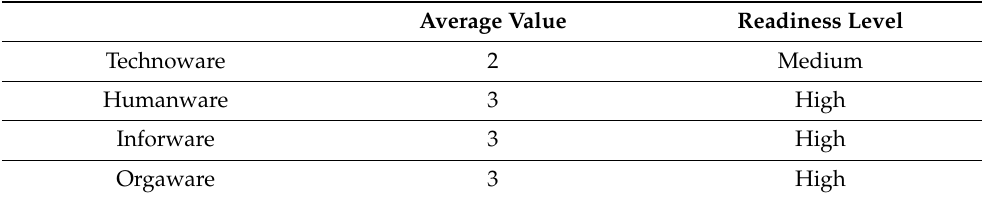
Table 6. The data-processing results for the readiness value of each component.